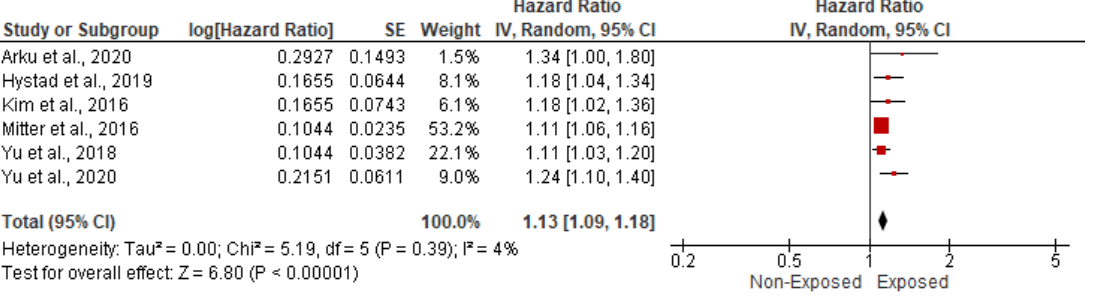
Figure 2. Forest plot of summary analysis of the hazard ratio and 95% CI of the association between HAP and CVD-related mortality. The size of the red squares is proportional to the statistical weight of each trial. The gray diamond represents the pooled point estimate. The positioning of both diamonds and squares (along with 95% CIs) beyond the vertical line (unit value) suggests a significant outcome (IV = inverse variance).